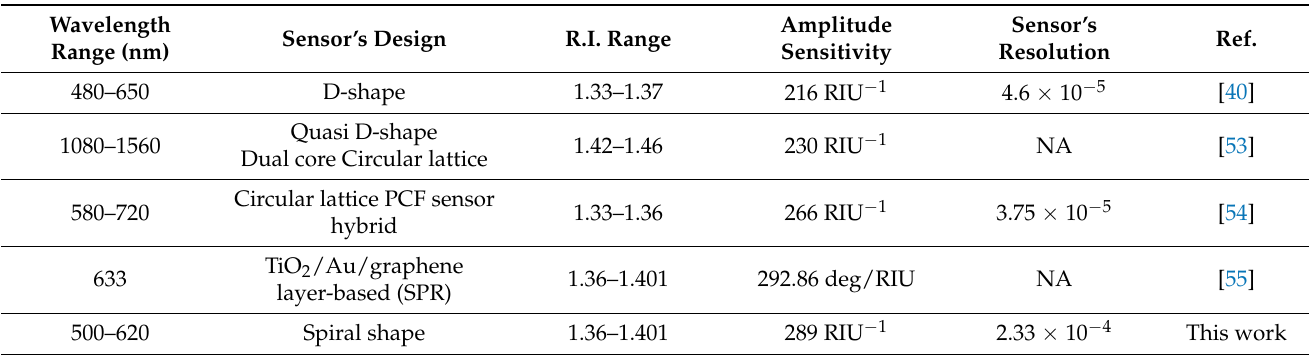
Table 3. Comparison between the proposed PCF-SPR biosensor’s design, wavelength range, RI range and sensitivity to existing